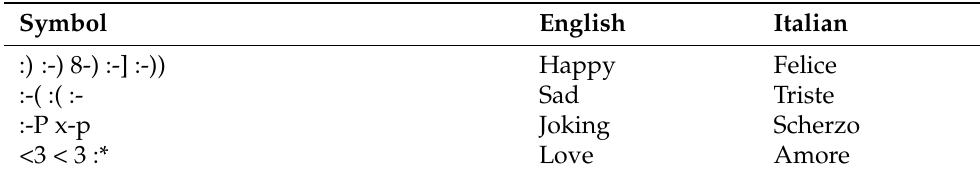
Table 1. Transformation of emoticons.